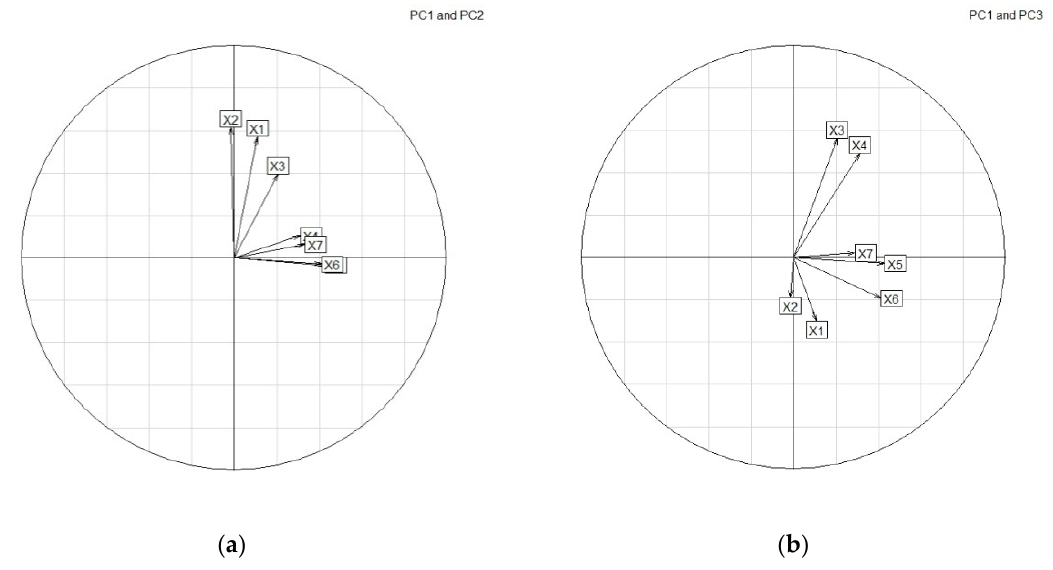
7 of 14 Figure 2. Scree plots of variance vs. PCs for load ( a ) and sustainability ( b ). Biplots obtained for input load and removal efficiency are shown in Figures 3 and 4, respectively. They present only PC1 vs. PC2 and PC1 vs. PC2 because PC2 vs. PC3 did not provide significant information about both data sets. These biplots only show the variables with higher weights in the first three PCs, which are those selected following the aforementioned rules. For input load, they were Energy Consumption (EC, X1), Input Flow (IF, X2), Number of Industrial Discharge (NID, X3), Total Suspended Solid (TSS, X4), Chemical Oxygen Demand (COD, X5), Biological